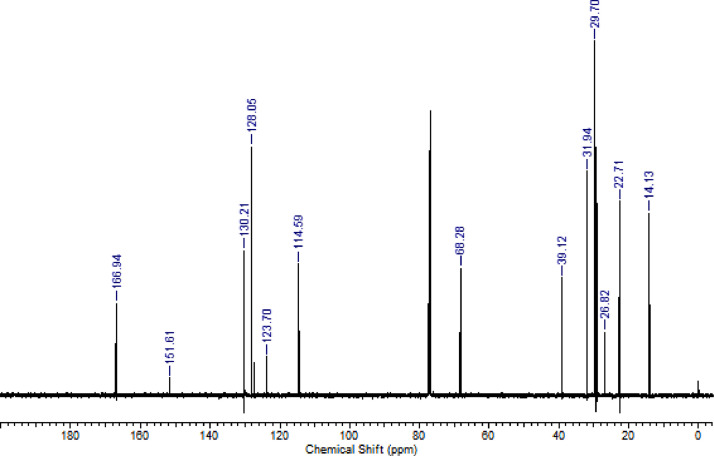
13C NMR (CDCl3, 100 MHz) spectrum of compound 8a.